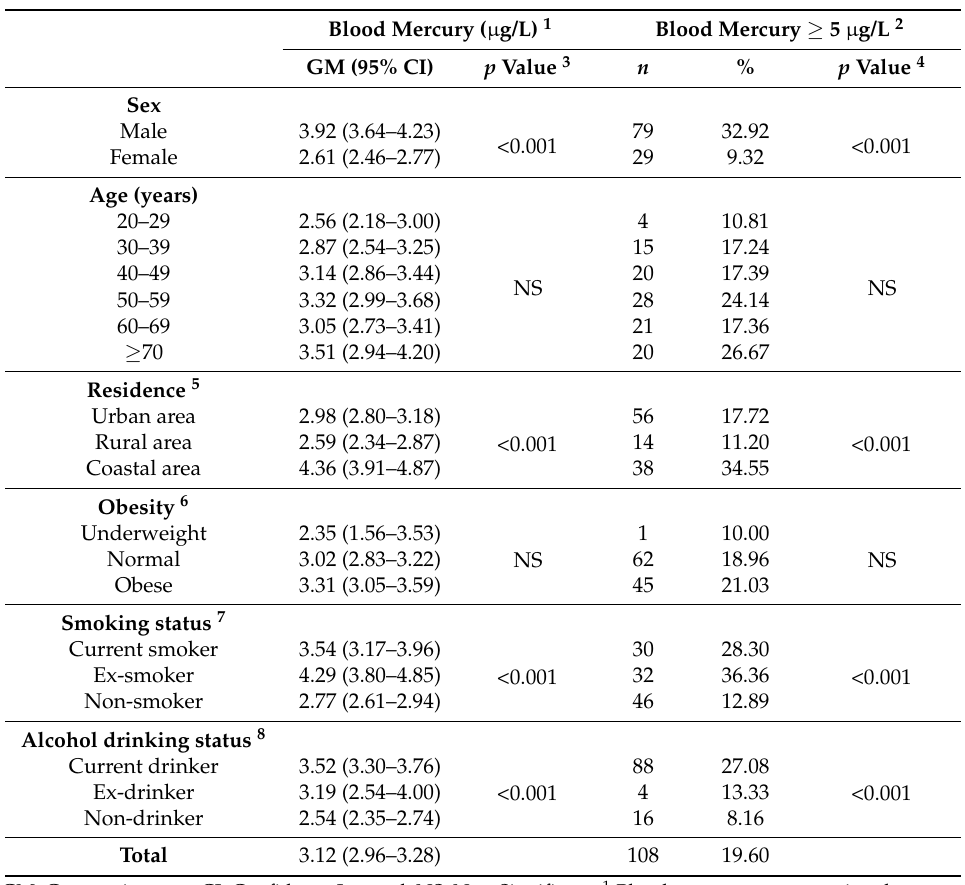
Table 3. The geometric mean of the blood mercury concentration and the percentage of people with blood mercury concentration ≥ 5 µ g/L (HBM I